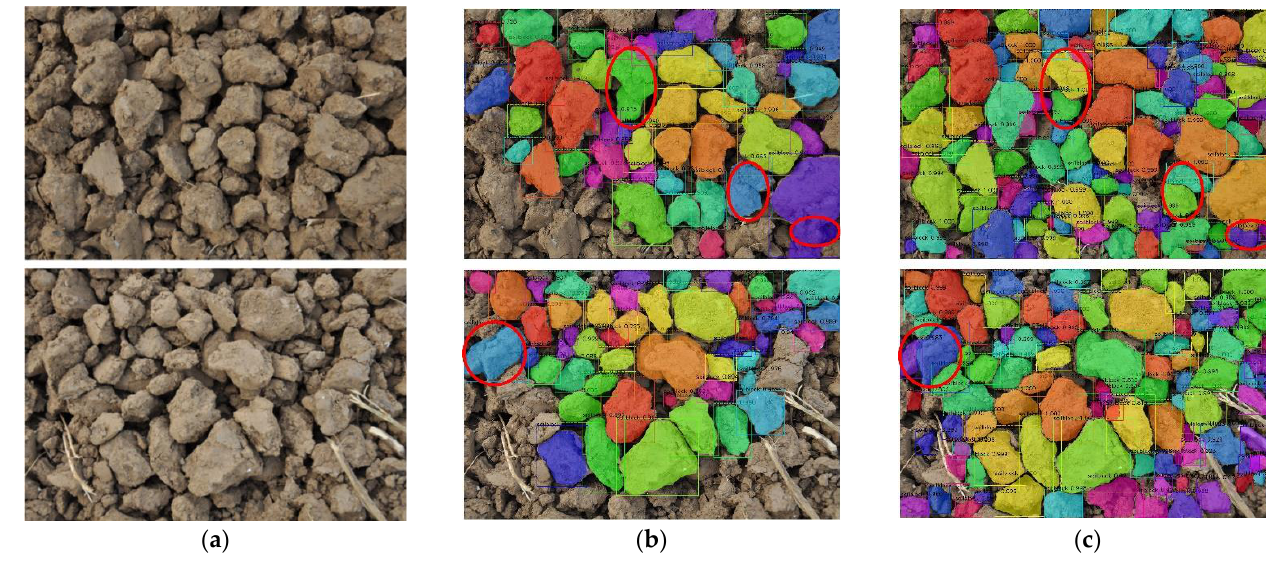
Figure 10. Detection results of large-scale soil blocks in the field. ( a ) the input image to be detected. ( b ) the detection effect of the unimproved algorithm. ( c ) the detection effect of the improved algorithm.